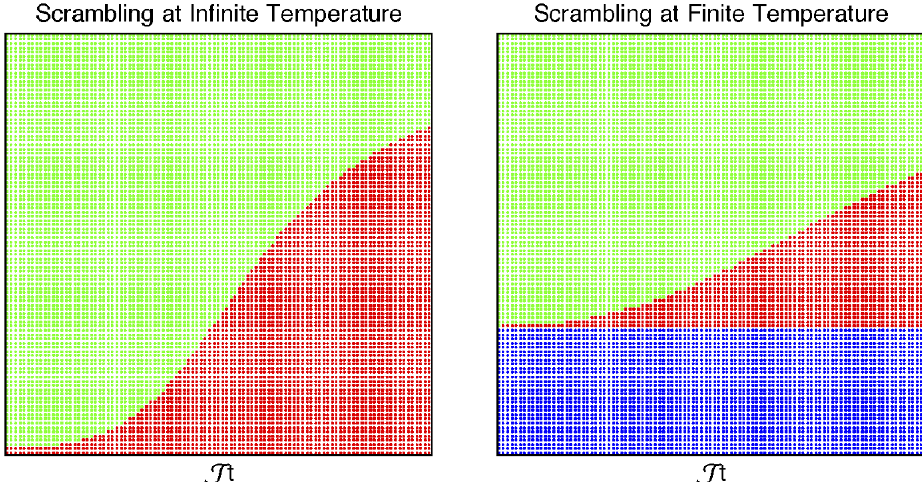
Figure 10 . Illustration of di(cid:11)erent epidemics at in(cid:12)nite temperature (left panel) and (cid:12)nite tem- perature (right panel). Green dots represents unexposed individuals, red dots represents contagious individuals, and blue dots represent vaccinated individuals. Finite temperature factors such as (cid:26) 1 = 2 \use up" some of the available (cid:13)avors for growth, resulting in collisions like those depicted in (cid:12)gure 5. This e(cid:11)ect ends up being well-modeled by an epidemic where these (cid:13)avors or individuals count as having been exposed, but do not spread disease. As a result of this large vaccinated population, it simply more rare for a contagious individual to encounter an unexposed individual, even at the start. Hence the rate of infection | the Lyapunov exponent | slows down, as seen in the right